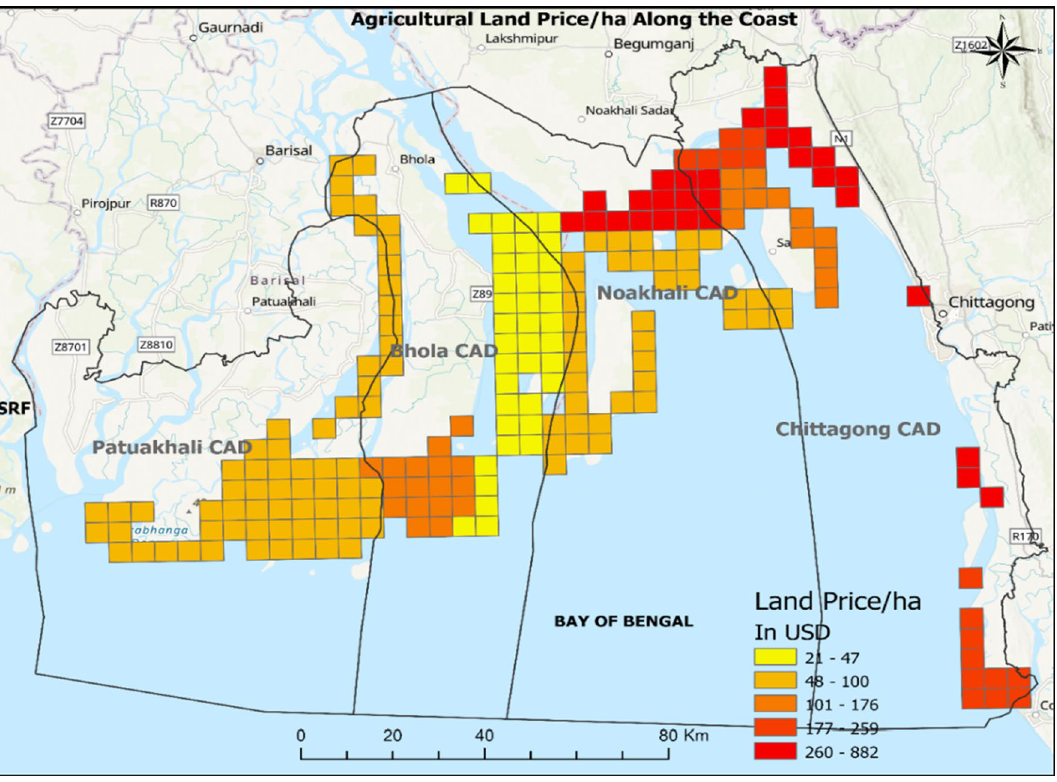
Fig. 3 Distribution of agricultural land price across the coast